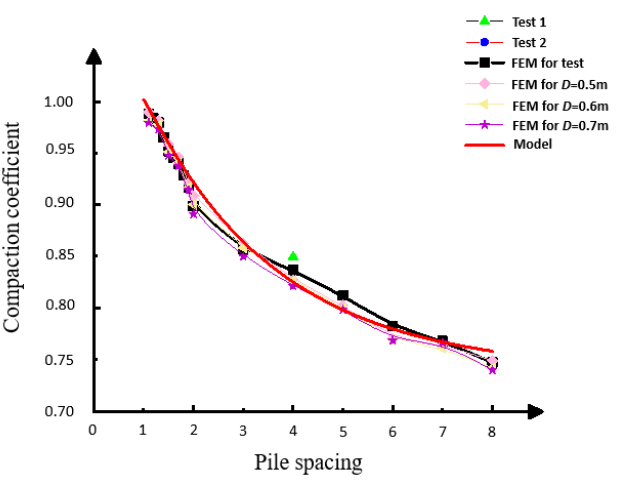
Figure 10. The relationship between the compaction coefficient at the edge midpoint and n.